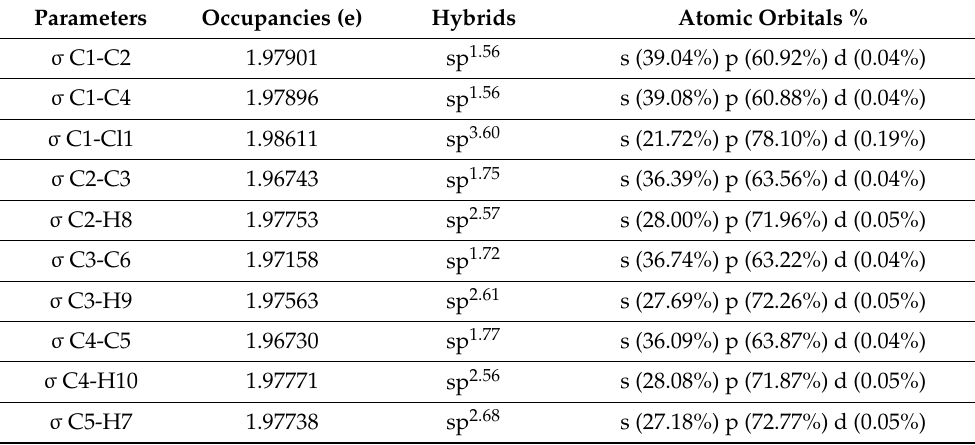
Table 2. Occupancy of natural orbitals and hybrids of compound for C,N,O,H,Cl